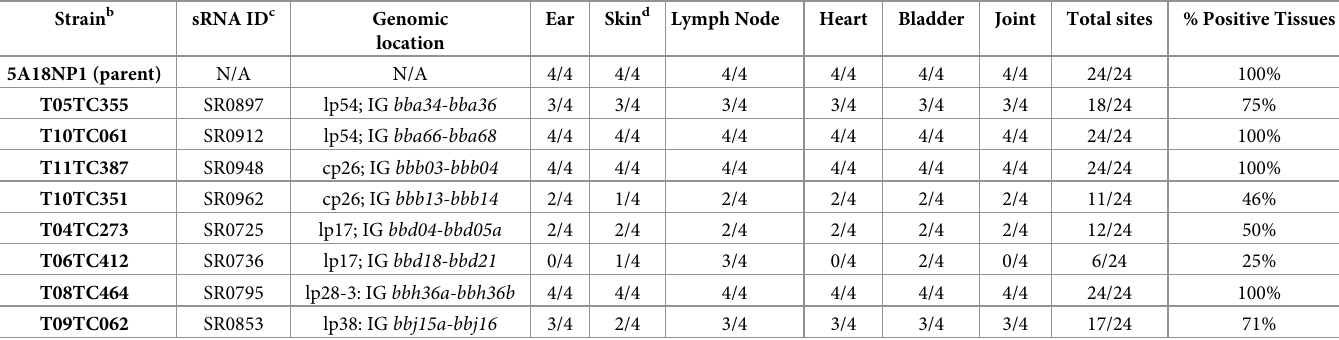
Table 2. Infectivity of B . burgdorferi intergenic (IG) sRNA transposon mutants relative to their genetic parent clone 5A18NP1 a